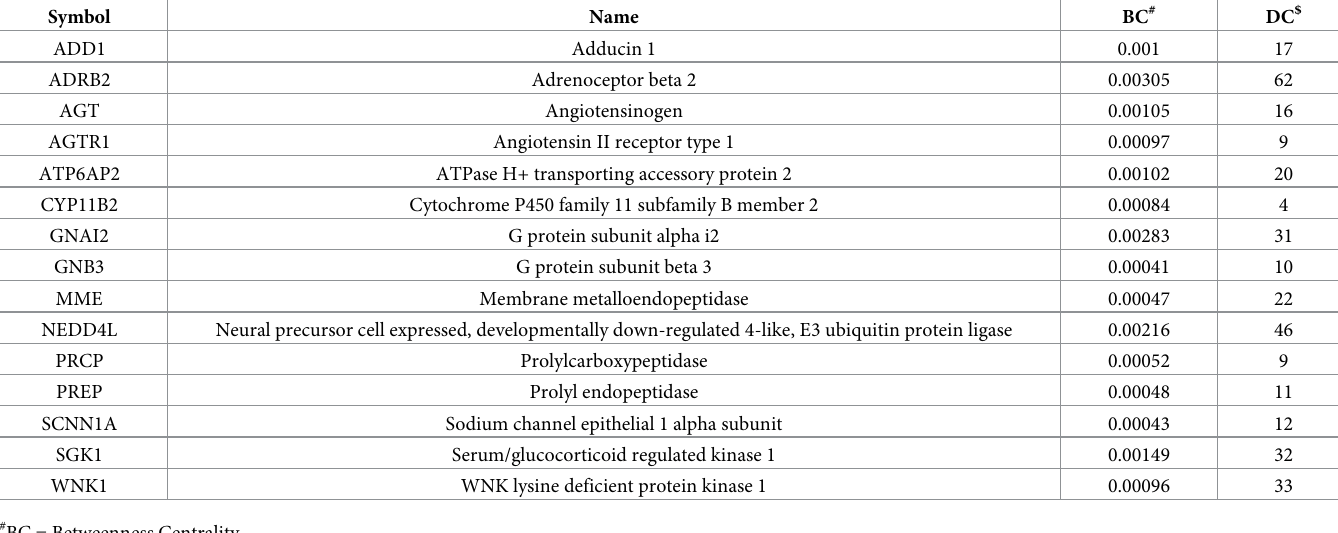
Table 2. The salt sensitivity genes overlapping with bottleneck